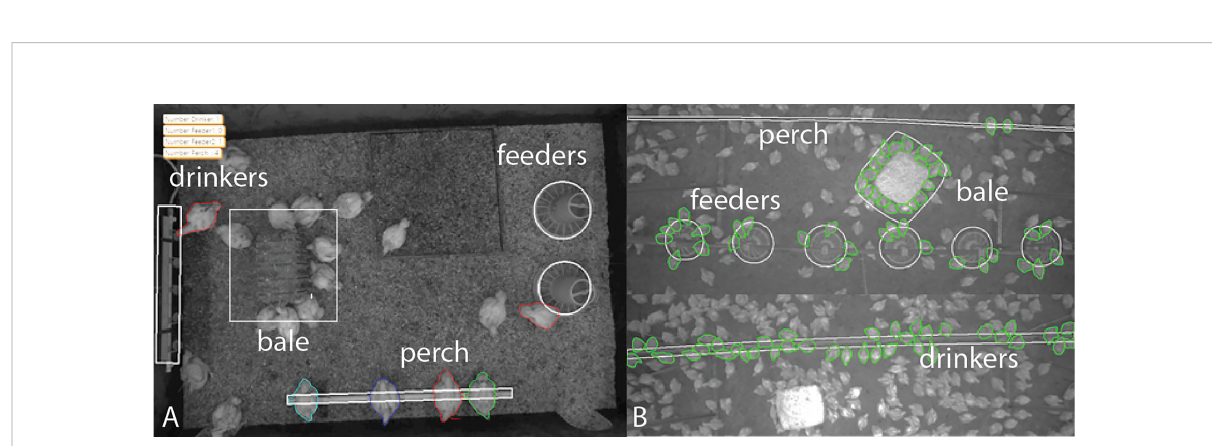
FIGURE 7 Examples of resource use in the (A) research facility and (B) commercial farm, the zones are visualized in white, the assigned broilers in